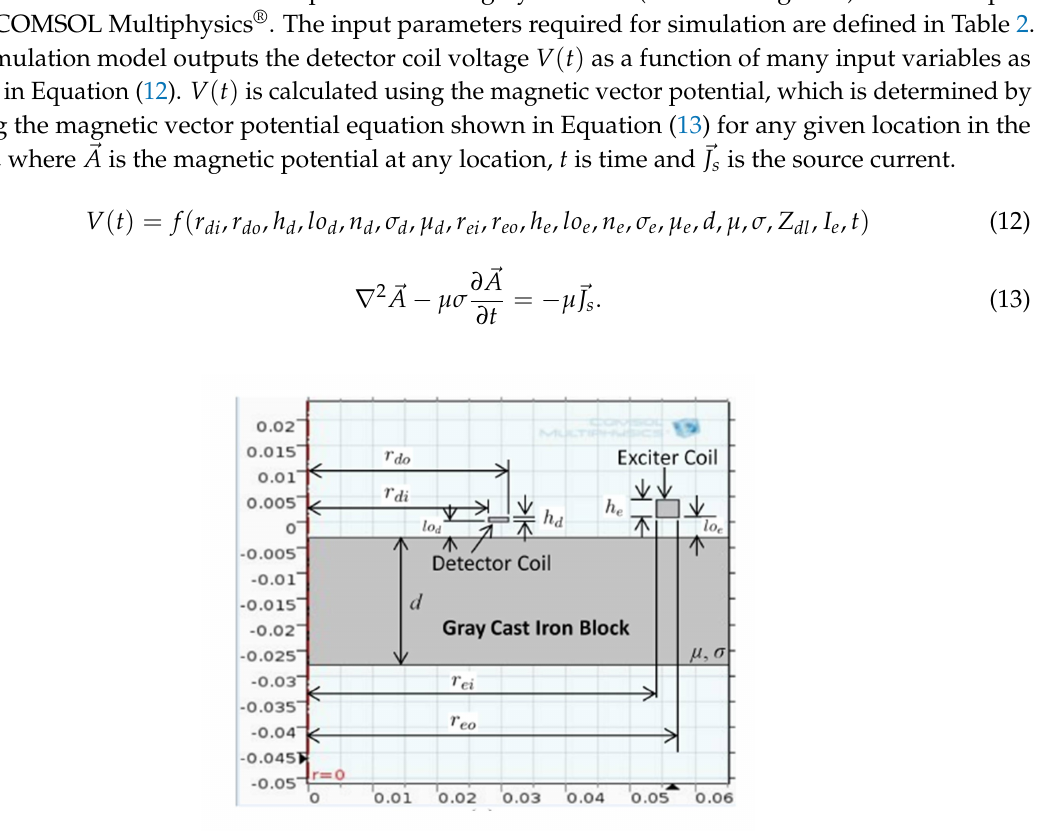
Figure 6. 2D axisymmetric model of the PEC sensor placed on a cast iron block (developed in COMSOL Multiphysics ® ). Table 2. Parameters required for